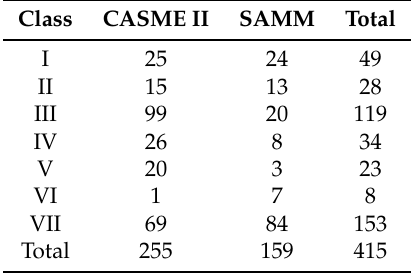
Table 3. The total number of movements assigned to the new classes for both SAMM and CASME II.